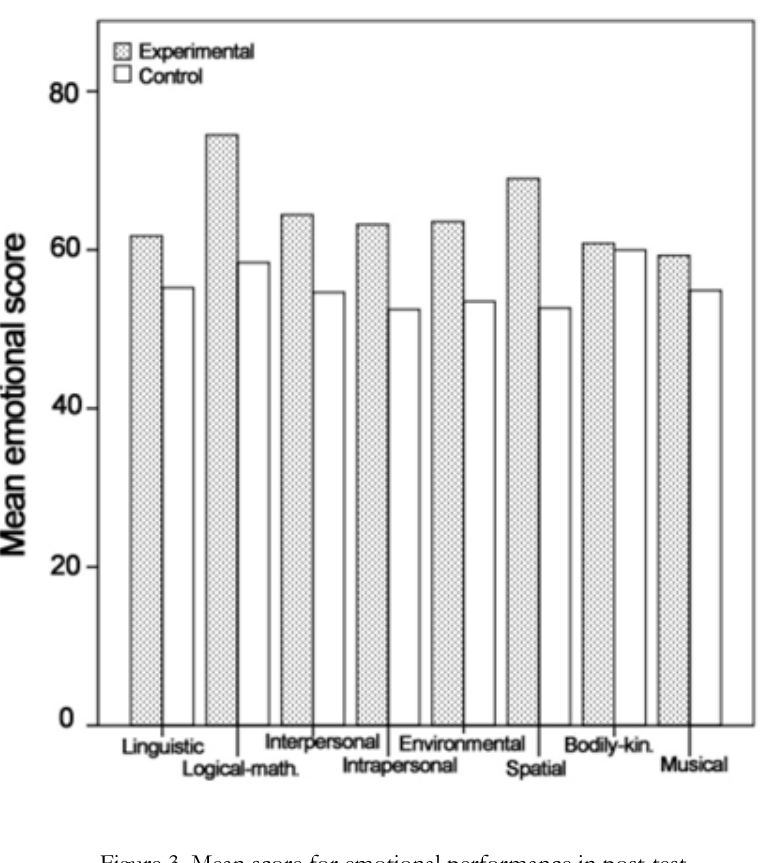
Figure 3. Mean score for emotional performance in post-test evaluation for Experimental and Control group segmented by IS. Confidence interval for error bars of 95%